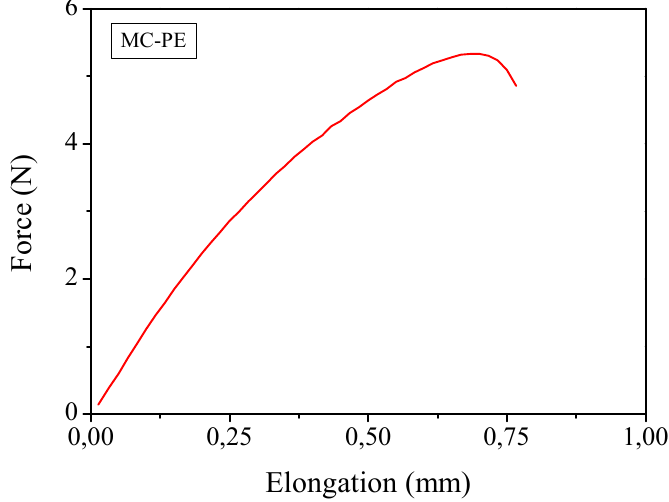
Figure 6. Mechanical measurements through traction test of the reinforced MC-PE at ambient temperature.